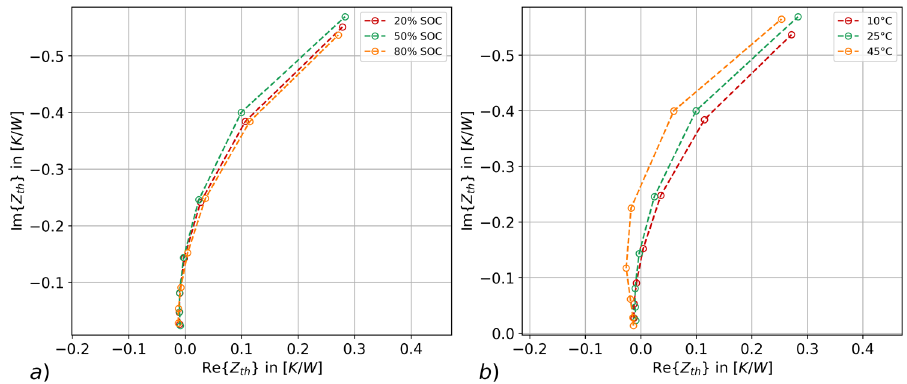
Figure 10. Comparison of the Nyquist plot when changing a test parameter: ( a ) adapting SOC value using 25 °C; ( b ) adapting temperature using SOC at 50%.